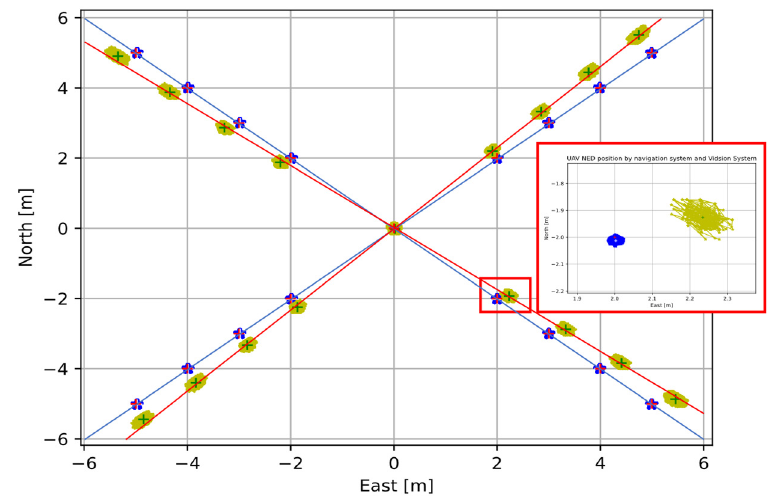
Figure 8. Data registration in twenty different flights. Yellow, UAV positions with vision system. Blue, UAV positions with navigation system. Blue and red line, linear approaches between navigation